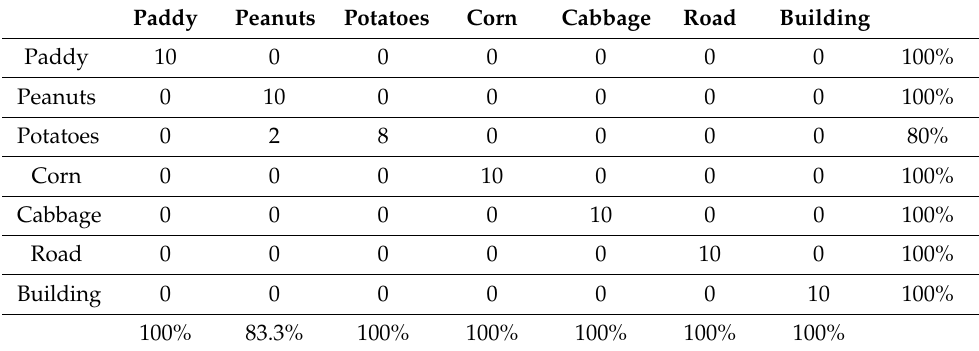
Figure 7 presents the convergence of PCA = 8 of 30 epochs. The x -axis is the epoch number and the y -axis is the predicted accuracy. The dot represents the accuracy of the training data with respect to different epochs. The line is the testing data with respect to different